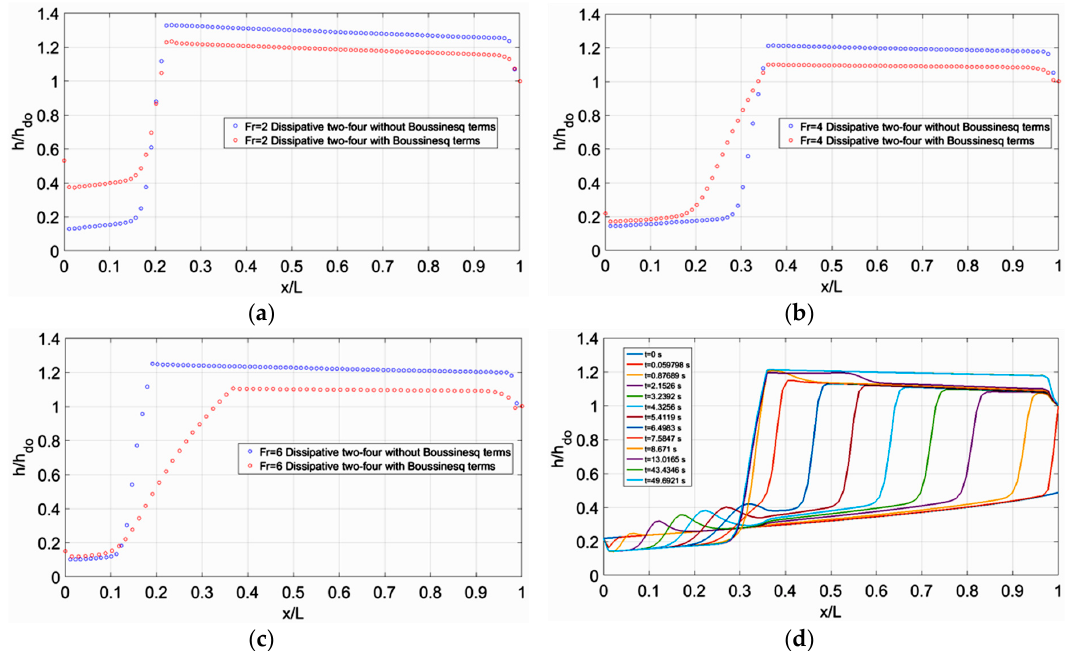
Figure 12. Dimensionless free surface elevation for 2 m wide channel: ( a ) for Fr = 2; ( b ) for Fr = 4; ( c ) for Fr = 6; ( d ) temporal evolution of the jump for Fr = 4.